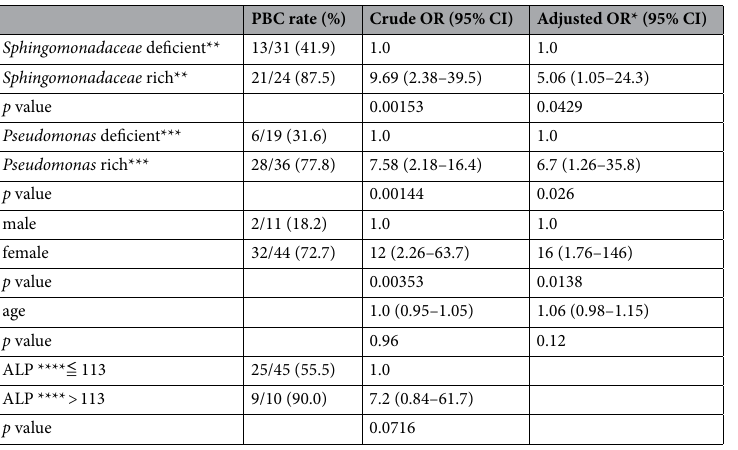
Table 2. Analysis of association factors contributing to PBC. *Logistic regression test was adjusted for covariates including gender and age. **The cutoff values were 0.0000179. ***The cutoff values were 0.0000684. ****The cutoff value of ALP was set as the upper limit of normal, which is the diagnostic criterion for PBC. PBC, primary biliary cholangitis; OR, odds ratio; CI, confidence interval; ALP, alkaline